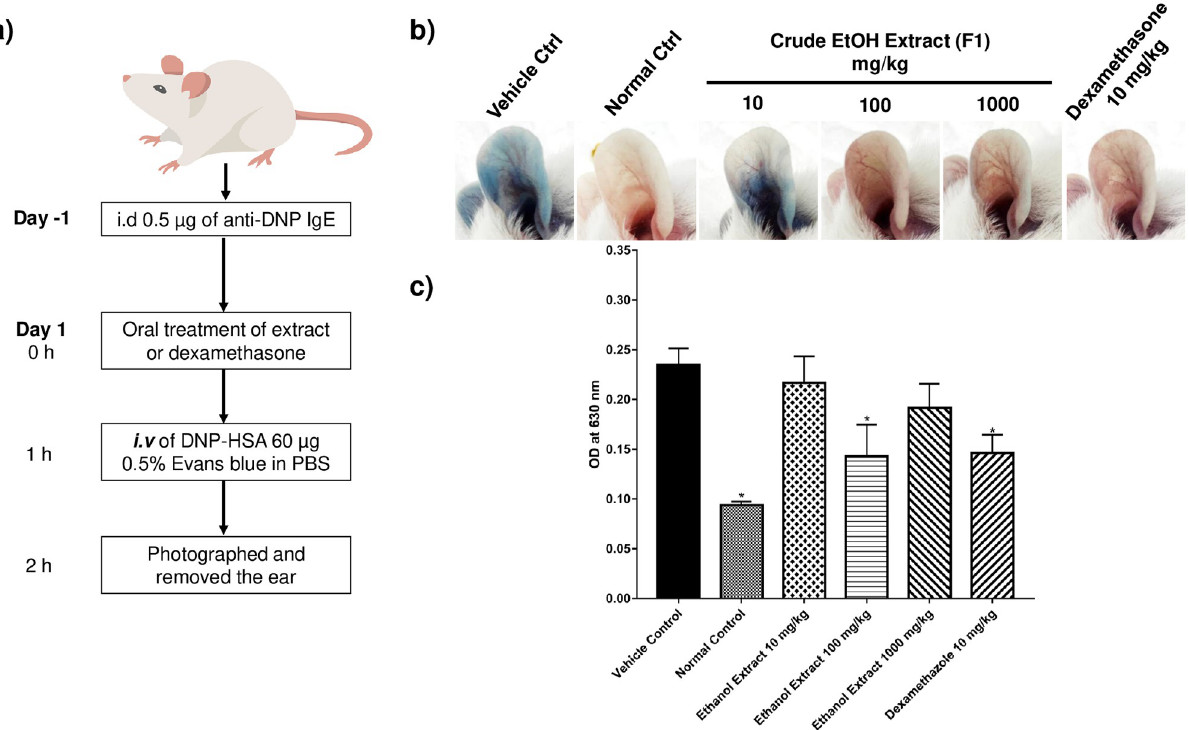
Fig 1. In vivo inhibitory effect of crude EtOH (F1) on IgE-mediated passive cutaneous anaphylaxis reaction. a) Experimental design of passive cutaneous anaphylaxis assay. Mouse ears were intradermally injected (i.d.) with anti-DNP-IgE. Twenty-four hours post sensitization, mice were orally administrated with F1 or dexamethasone then intravenously (i.v.) challenged with DNP antigen. Evans blue leakage was monitored at 2 hours after stimulation. b) Evans blue leakage after the antigen challenge. Dexamethasone was used as a positive control. c) Evans blue extracted from each ear was quantified using a spectrophotometer. Data are presented as mean ± SEM (n = 5 per group). � p < 0.05, compared with the vehicle control group.